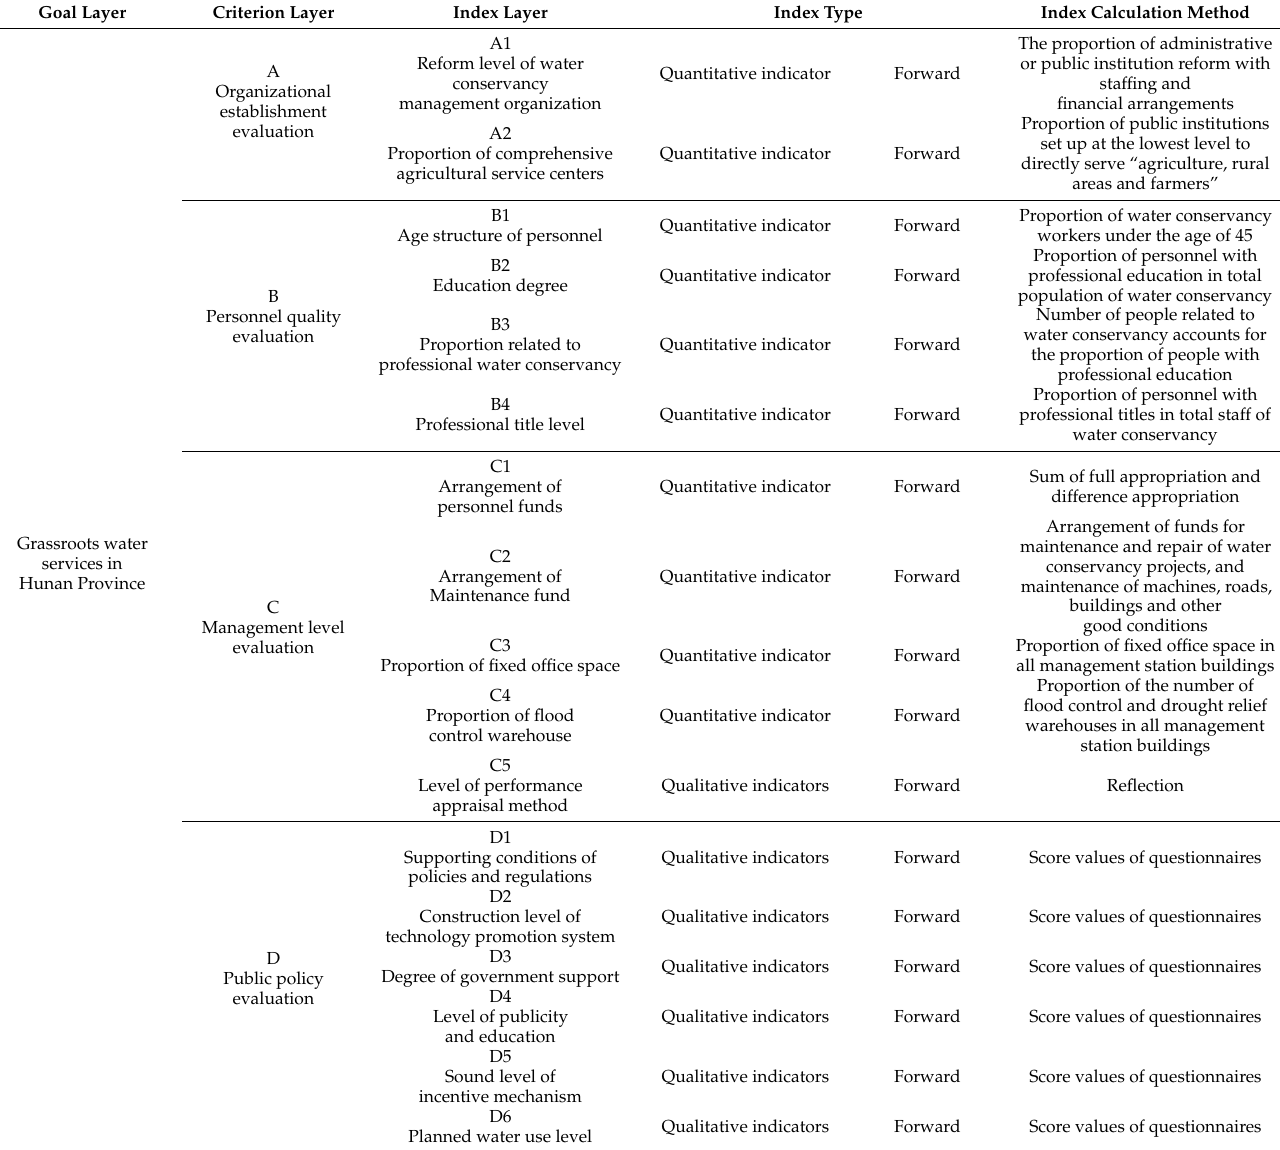
Table 1. Selection and characterization of evaluation